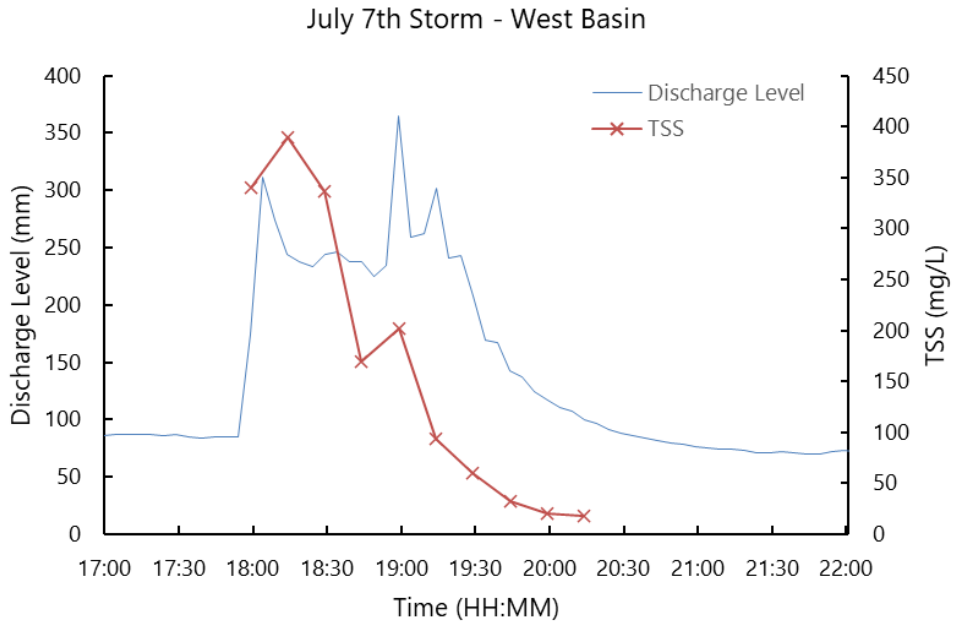
Figure 4. Discretely analyzed storm showing evidence of first-flush effect for TSS at the West basin for the storm occurring on 7 July 2018. Blue line represents the hydrograph, and the red line represents the TSS concentration.